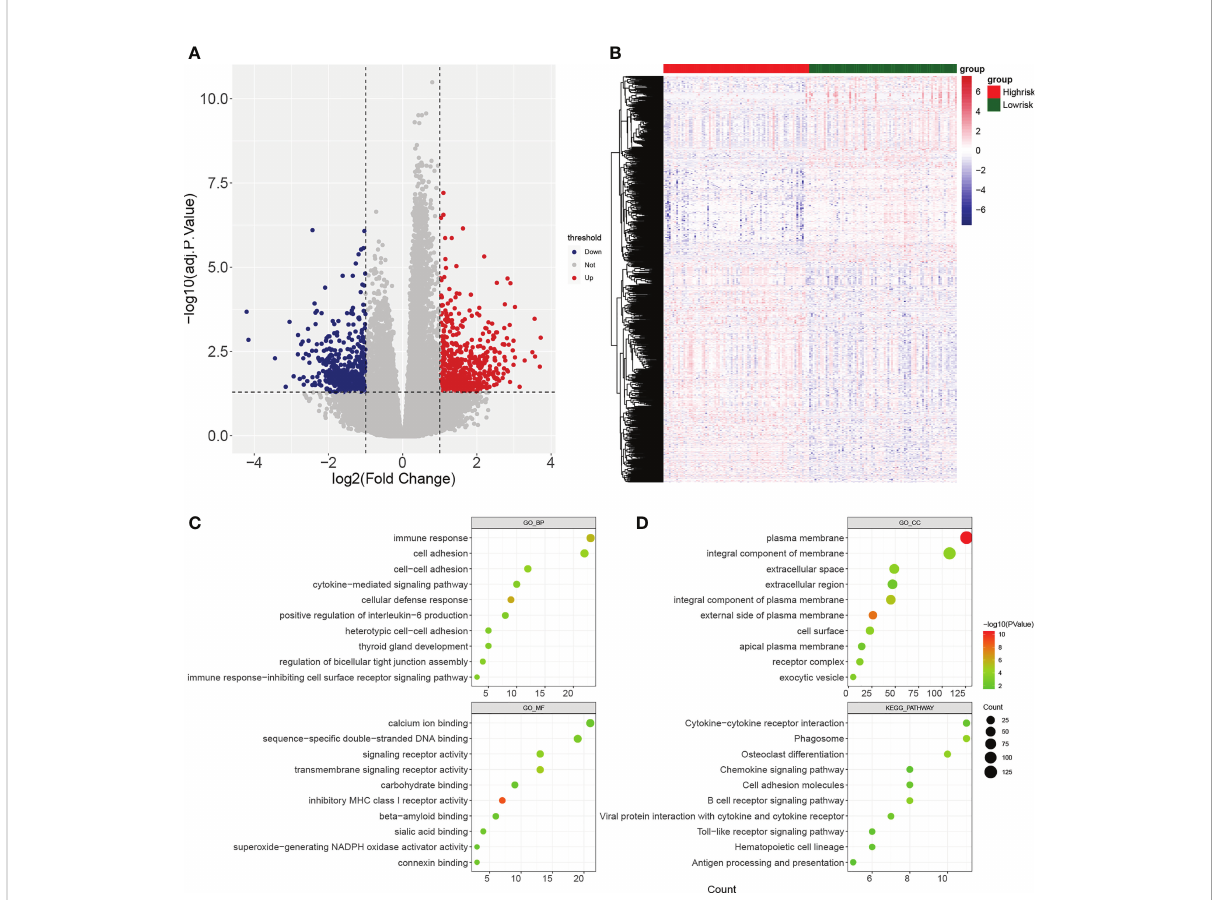
FIGURE 7 Identi fi cation of differentially expressed genes (DEGs) between high- and low-risk groups. (A, B) Volcano plot and heatmap of DEGs fi ltered with adj.p.< 0.05 and |log 2 fold change (FC)| > 1. (C, D) Bubble diagrams of GO enrichment analysis and KEGG pathway analysis ( p <